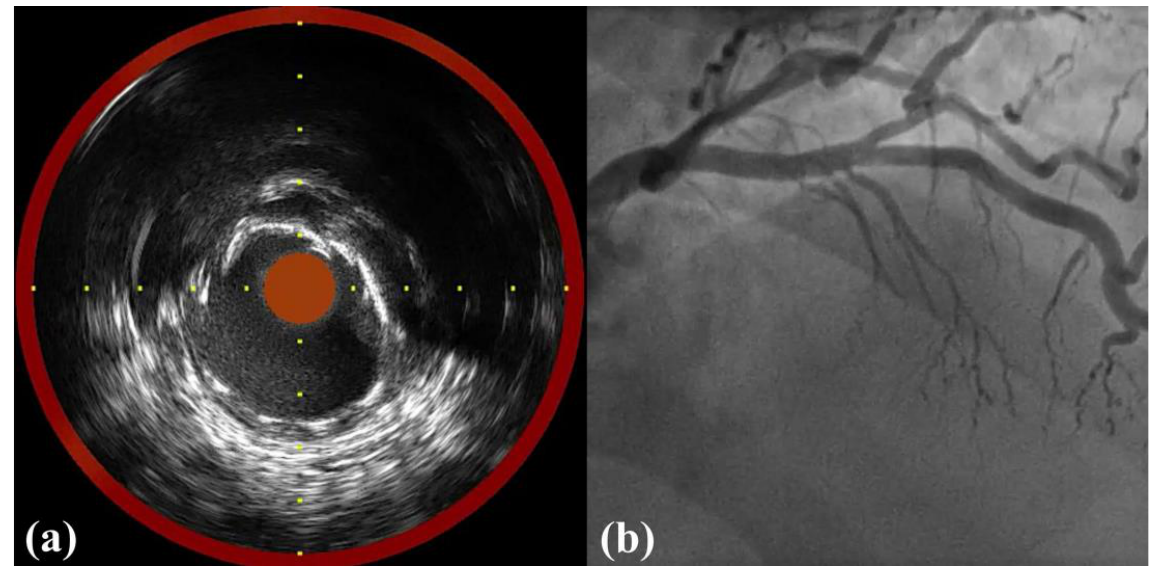
Figure 3. Post-procedural NIRS-IVUS and CAG images. NIRS-IVUS pullback after the non-compliant balloon demonstrated no edge dissection, no malapposition, and minimal underexpansion ( a ). Fi- nal CAG showed excellent results ( b ). CAG, coronary angiography; NIRS-IVUS, near-infrared spectroscopy intravascular